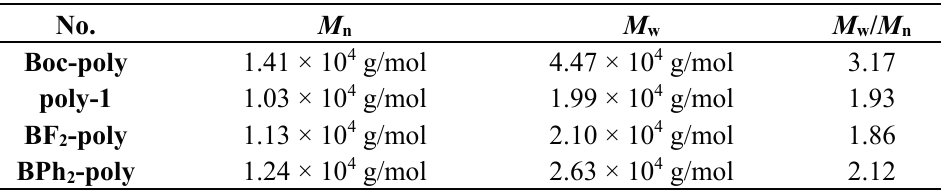
Table 1. Summary of gel permeation chromatography (GPC) data for obtained polymers.